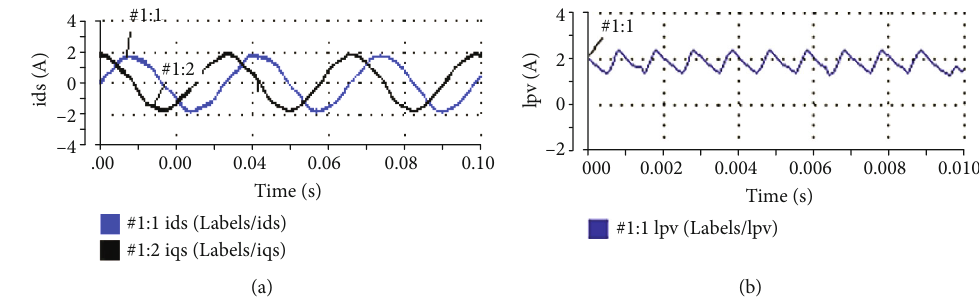
I ds and qs ; (b) zoom on PV array current